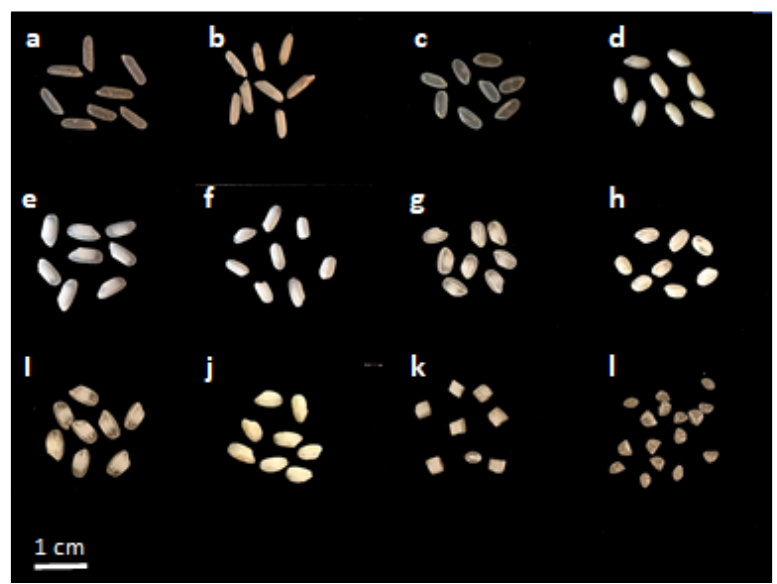
Figure 1. Milled rice grains photographs of the different cultivars used in this study. ( a , b ), Olesa and chalky Olesa; ( c , d ), Guadiamar and chalky Guadiamar; ( e , f ), Carnaroli and chalky Carnaroli; ( g , h ), Bomba and chalky Bomba; ( i , j ), Montsianell and chalky Montsianell; ( k , l ), pearl and crystalline fractions of the rice grains.